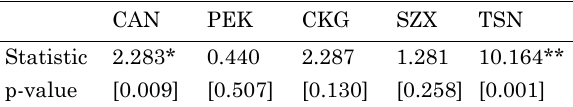
Table 9. Weak exogeneity